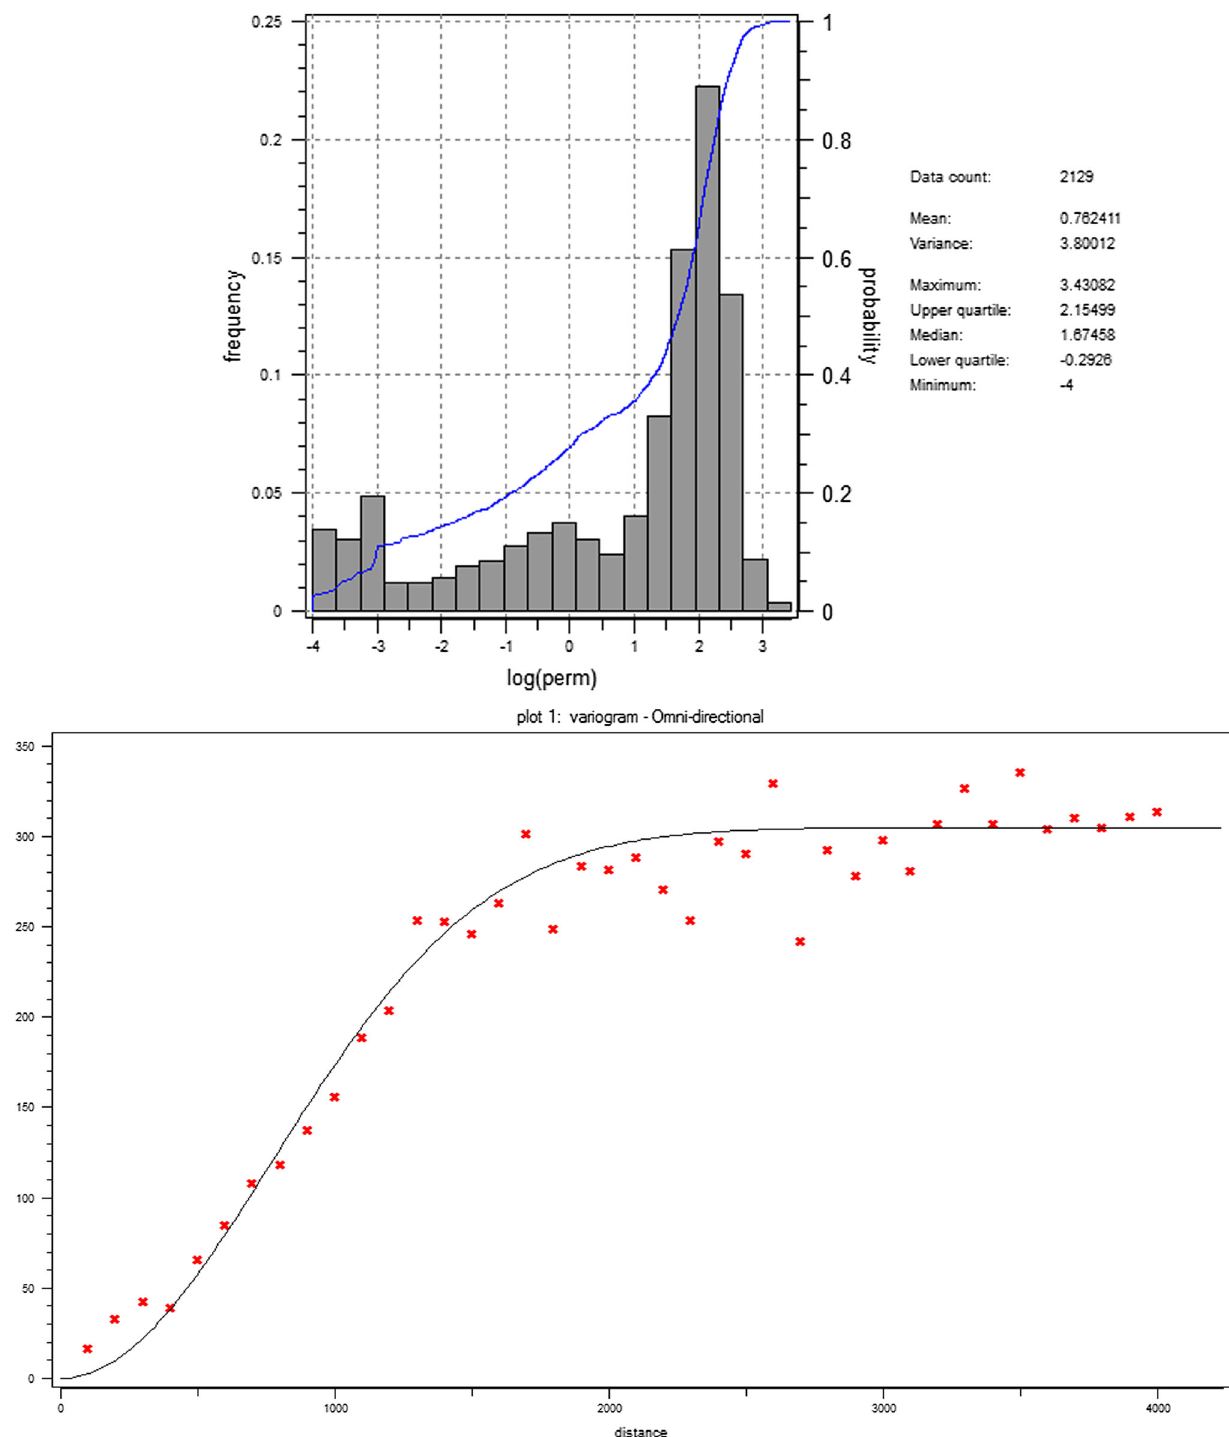
Fig. 4 Permeability histogram and variogram for the reservoir